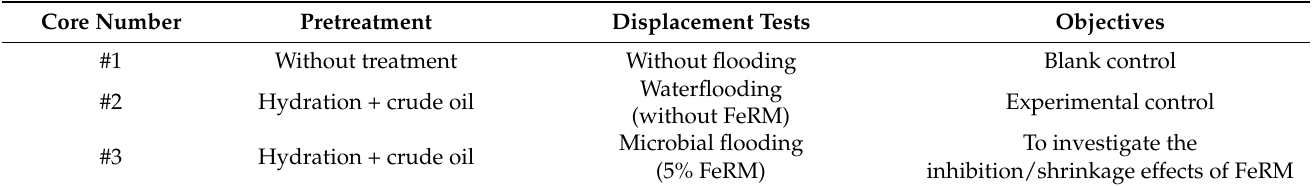
Table 2. Experimental design of core displacement